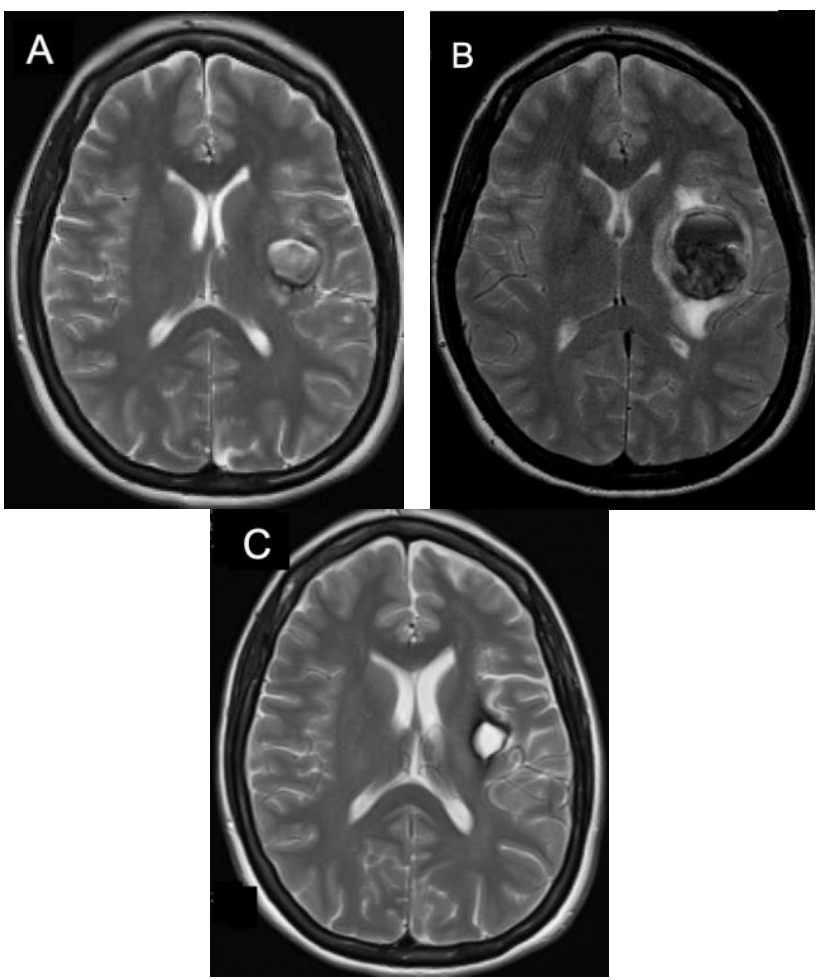
Figure 3. Operative Symptomatic Supratentorial CCM. T2 axial MRI of a patient with an enlarging hemorrhagic left insula CCM initially presenting with word finding difficulties and right sided weakness ( A ). The CCM was found to have enlarged over the next three months ( B ). The patient underwent surgical resection she experienced almost immediate resolution of her symptoms with T2 MRI imaging three months after surgery showing complete resection ( C ).